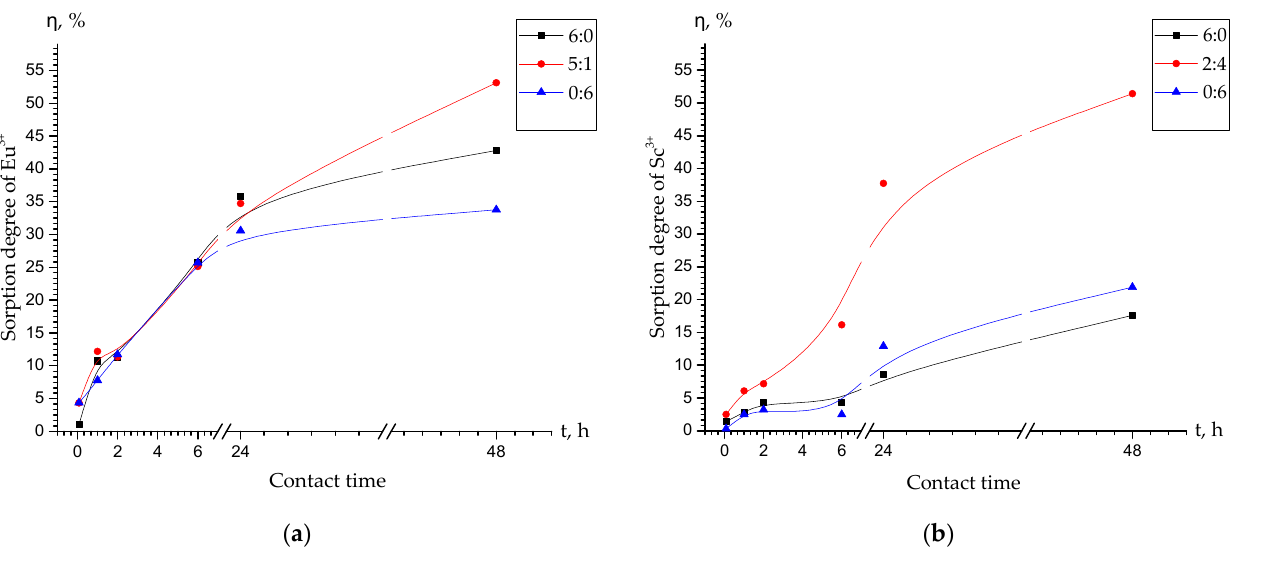
Figure 7. The dependence of the ( a ) europium and ( b ) scandium ions sorption degree as a function of time.